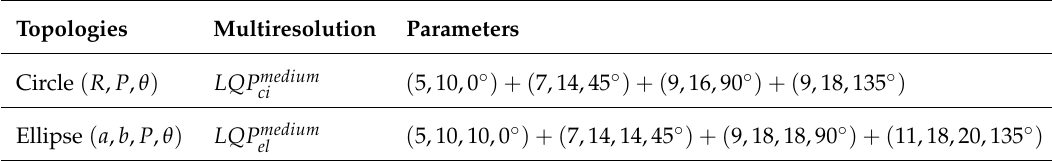
Table 3. Parameter values for different neighbourhood topologies and orientations.